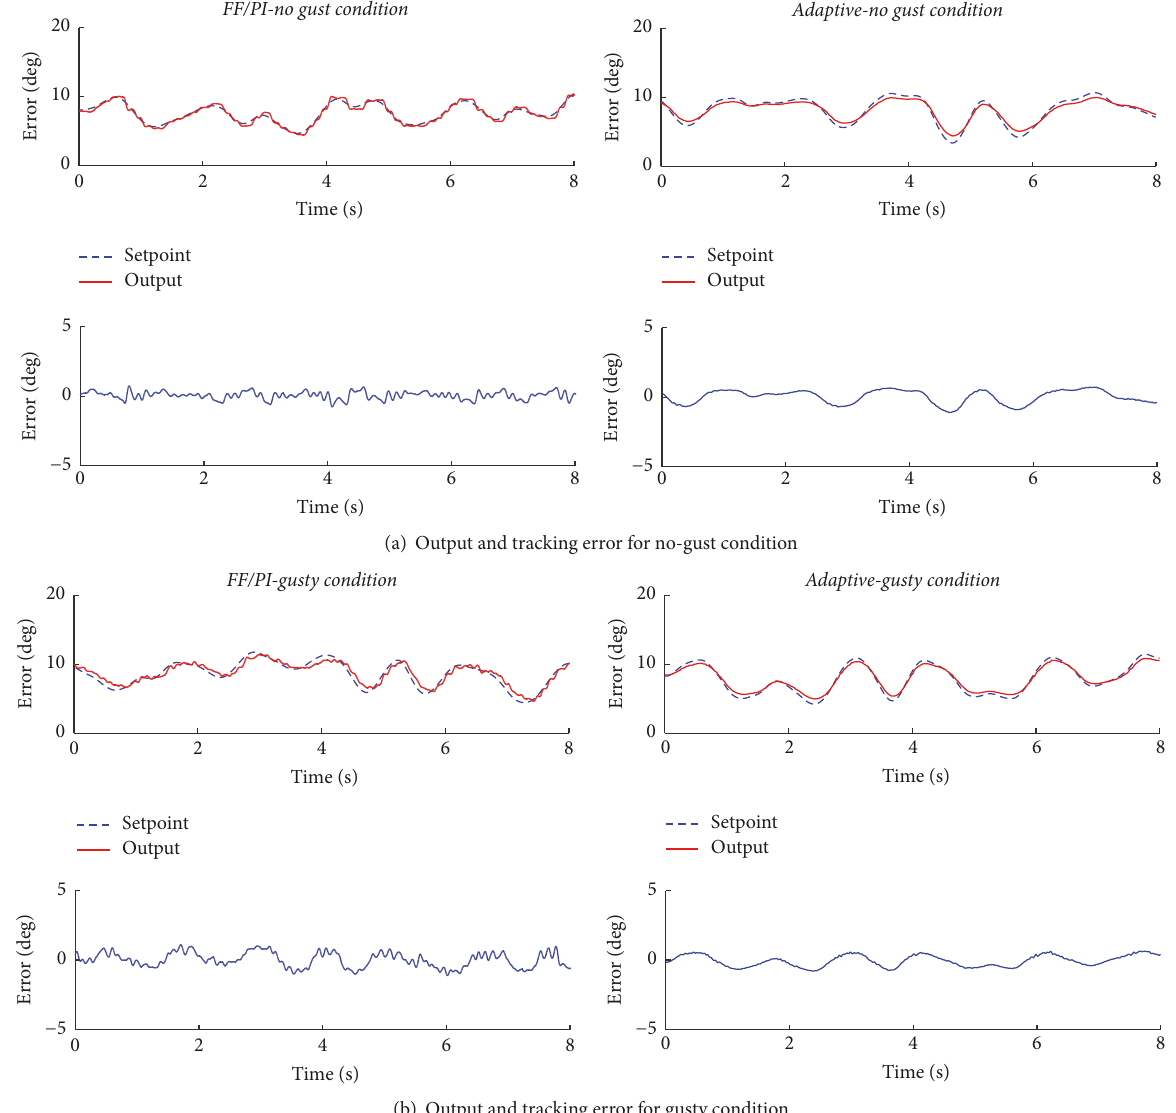
Figure 9: Controller performances of the wing warping with tendon-sheath actuation under no-gust and gusty environments with wind speed of 7m/s. The left panels show the case with feedforward/feedback controller; the right panels show the case of adaptive backstepping